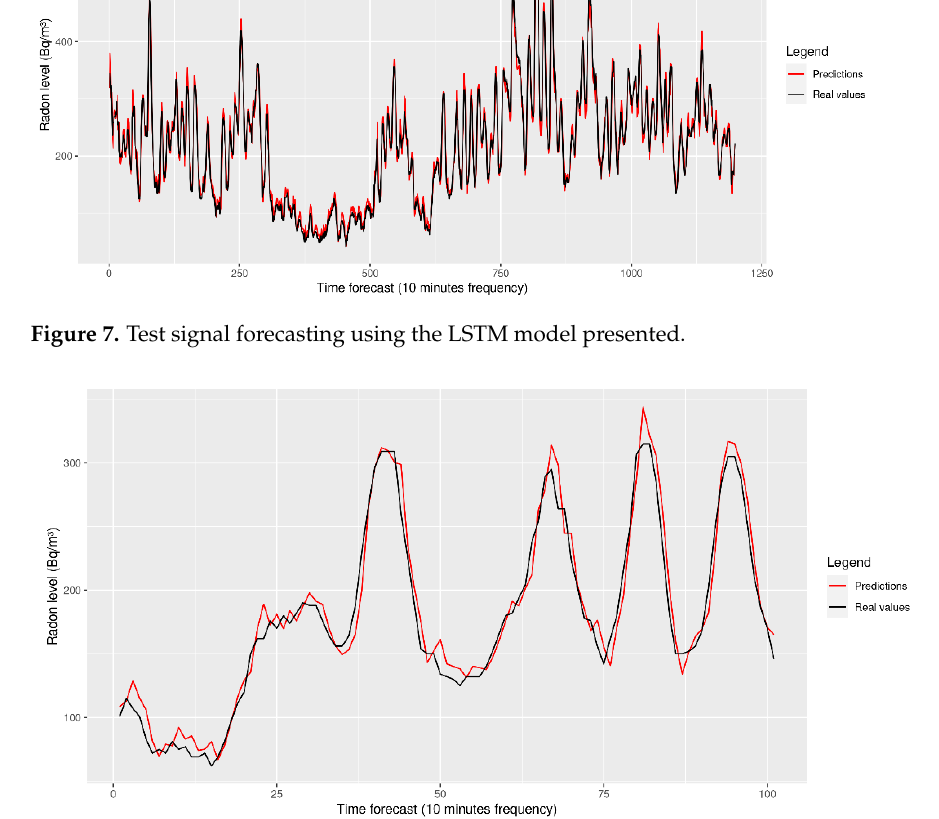
Figure 8. Closer look at the LSTM forecasting.